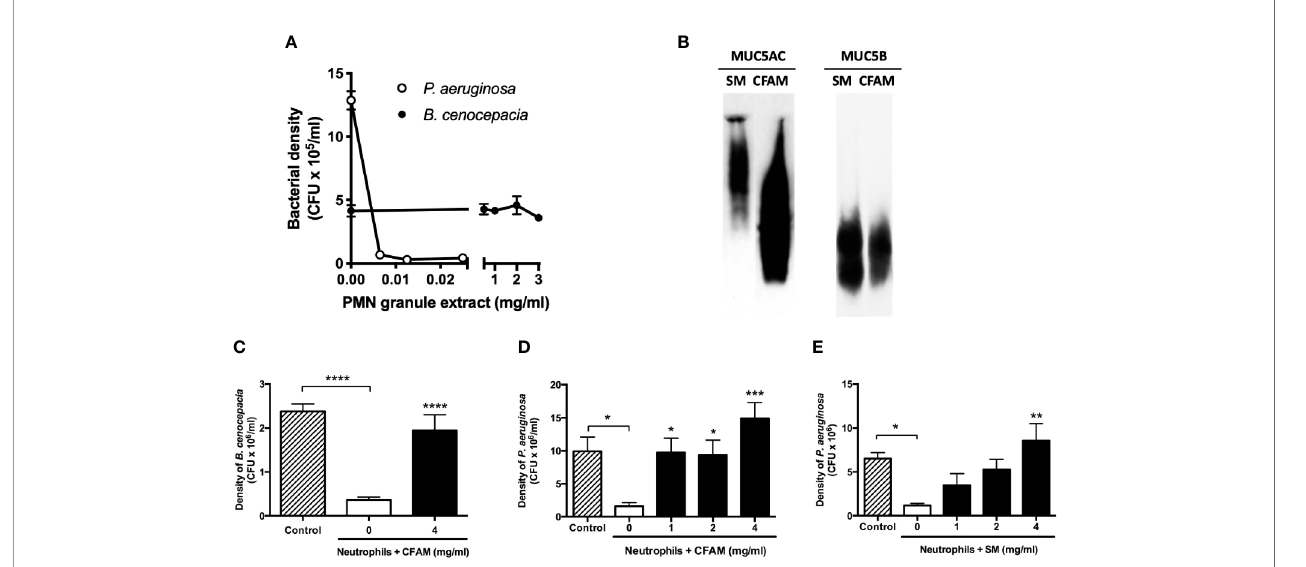
FIGURE 1 | Bacterial killing by neutrophil granule extracts and neutrophils with and without mucins. (A) Human neutrophil granule extracts markedly inhibited Pseudomonas aeruginosa (PAO1) growth but did not affect Burkholderia cenocepacia (C5424) density (n = 3). (B) Characterization of CF airway mucins (CFAM) and salivary mucins of healthy volunteers (SM). Samples of CFAM (200 m g) and SM (200 m g) were separated on a 0.7% agarose gel. The proteins were transferred to nitrocellulose membranes and revealed with either goat polyclonal mucin MUC5B IgG or MUC5AC concentrated Clone B442 antibody. (C) Neutrophil killing of B. cenocepacia (n = 9) and (D) P. aeruginosa (n = 9) in the absence or presence of CFAM or (E) SM (n = 7). CFAM and SM suppressed neutrophil-mediated killing of PAO1 and C5424 bacteria after incubation for 2 h at 37°C. (n = 9, * P < 0.05, ** P < 0.01, *** P < 0.001, **** P < 0.0001).